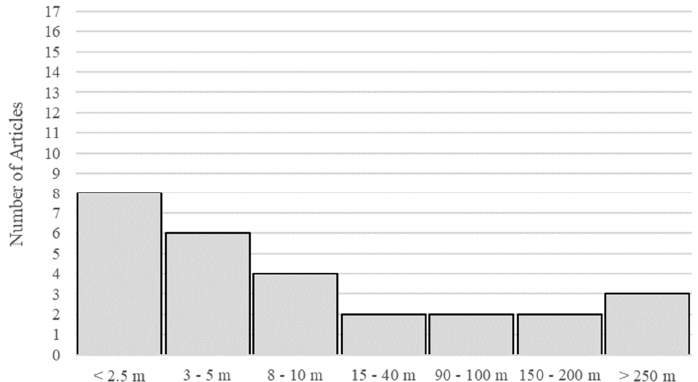
Figure 2. The range of resolutions presented or discussed in the articles.